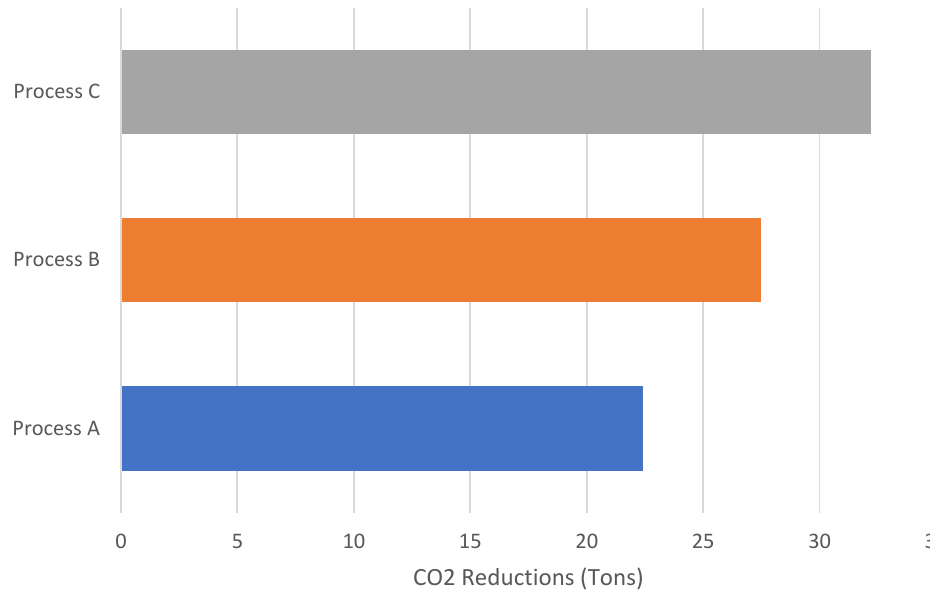
Figure 9. CO 2 reductions per annum.